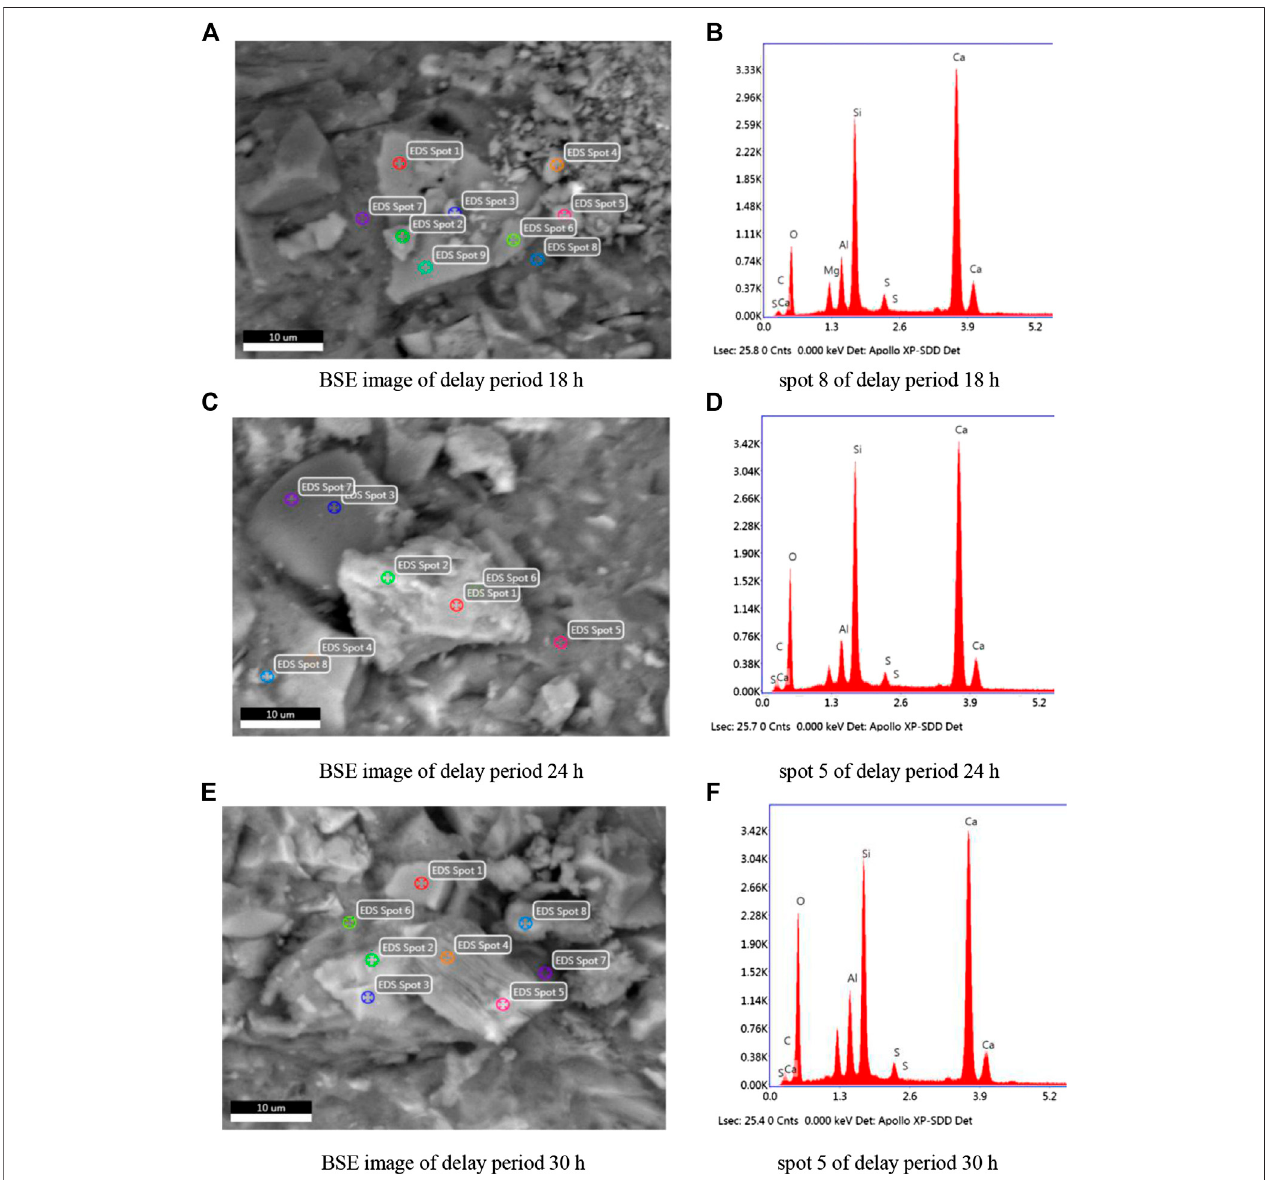
Figure 11 | Elemental energy spectrum of hydration products under different delay period. (A) BSEimage of delay period 18 h. (B) spot eight ofdelay period 18 h. (C) BSE image of delay period 24 h. (D) spot fi ve of delay period 24 h. (E) BSE image of delay period 30 h. (F) spot fi ve of delay period 30 h.